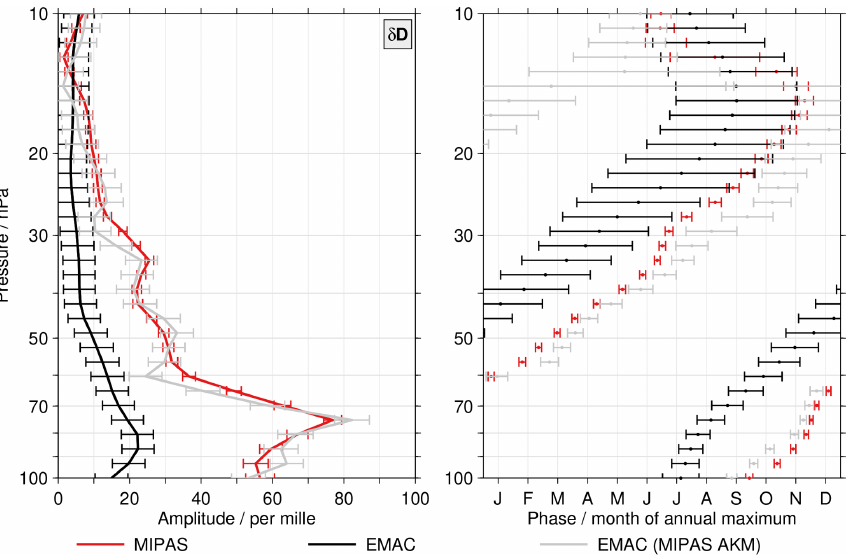
Figure 14. As for Figs. 3 and 4 but here focusing son EMAC results. For the original EMAC data, the results are shown in black; the results based on the convolution with the MIPAS averaging kernels are presented in grey. The original MIPAS results are shown in